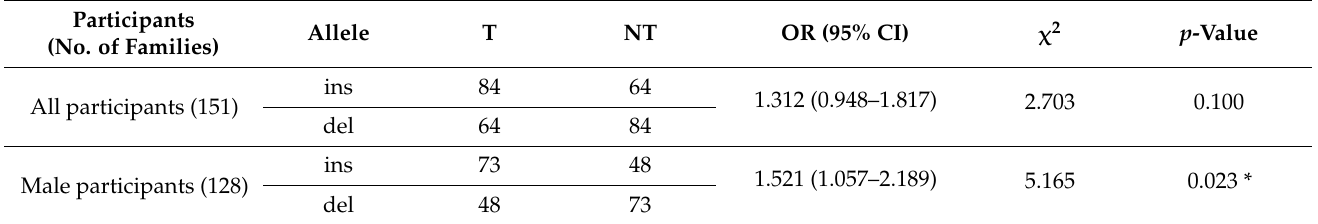
Table 2. Transmission disequilibrium test results between ins and del alleles in patient